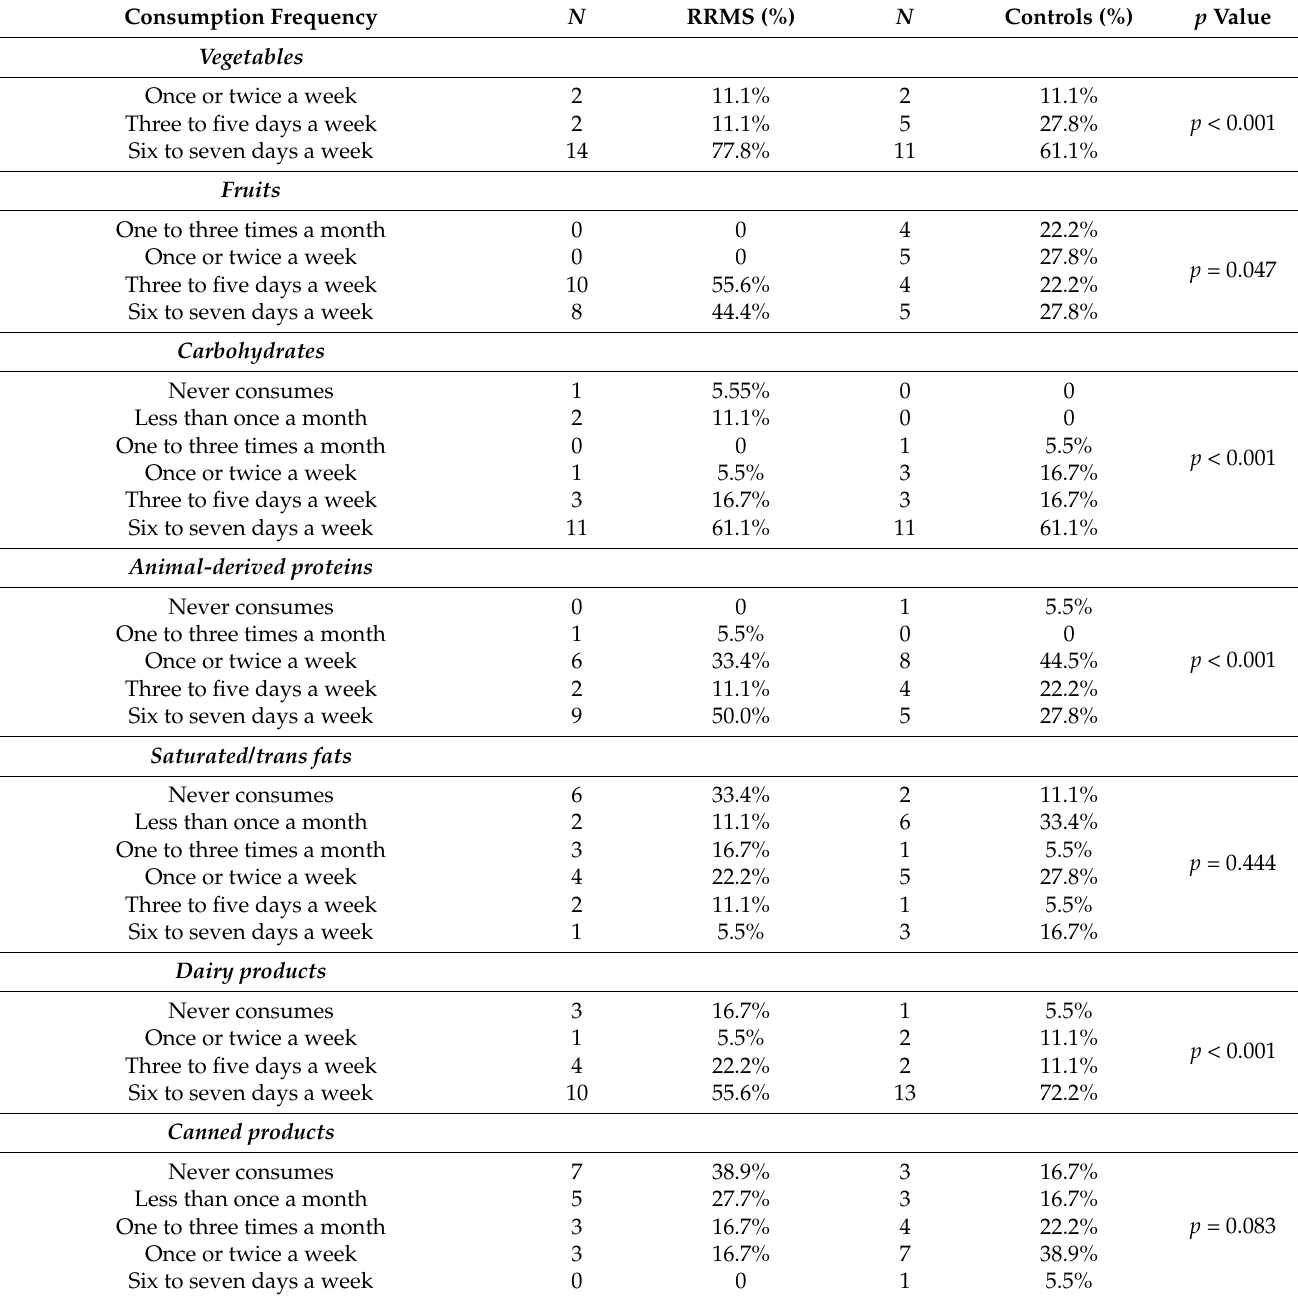
Table 2. Description of the dietary habits of multiple sclerosis patients and